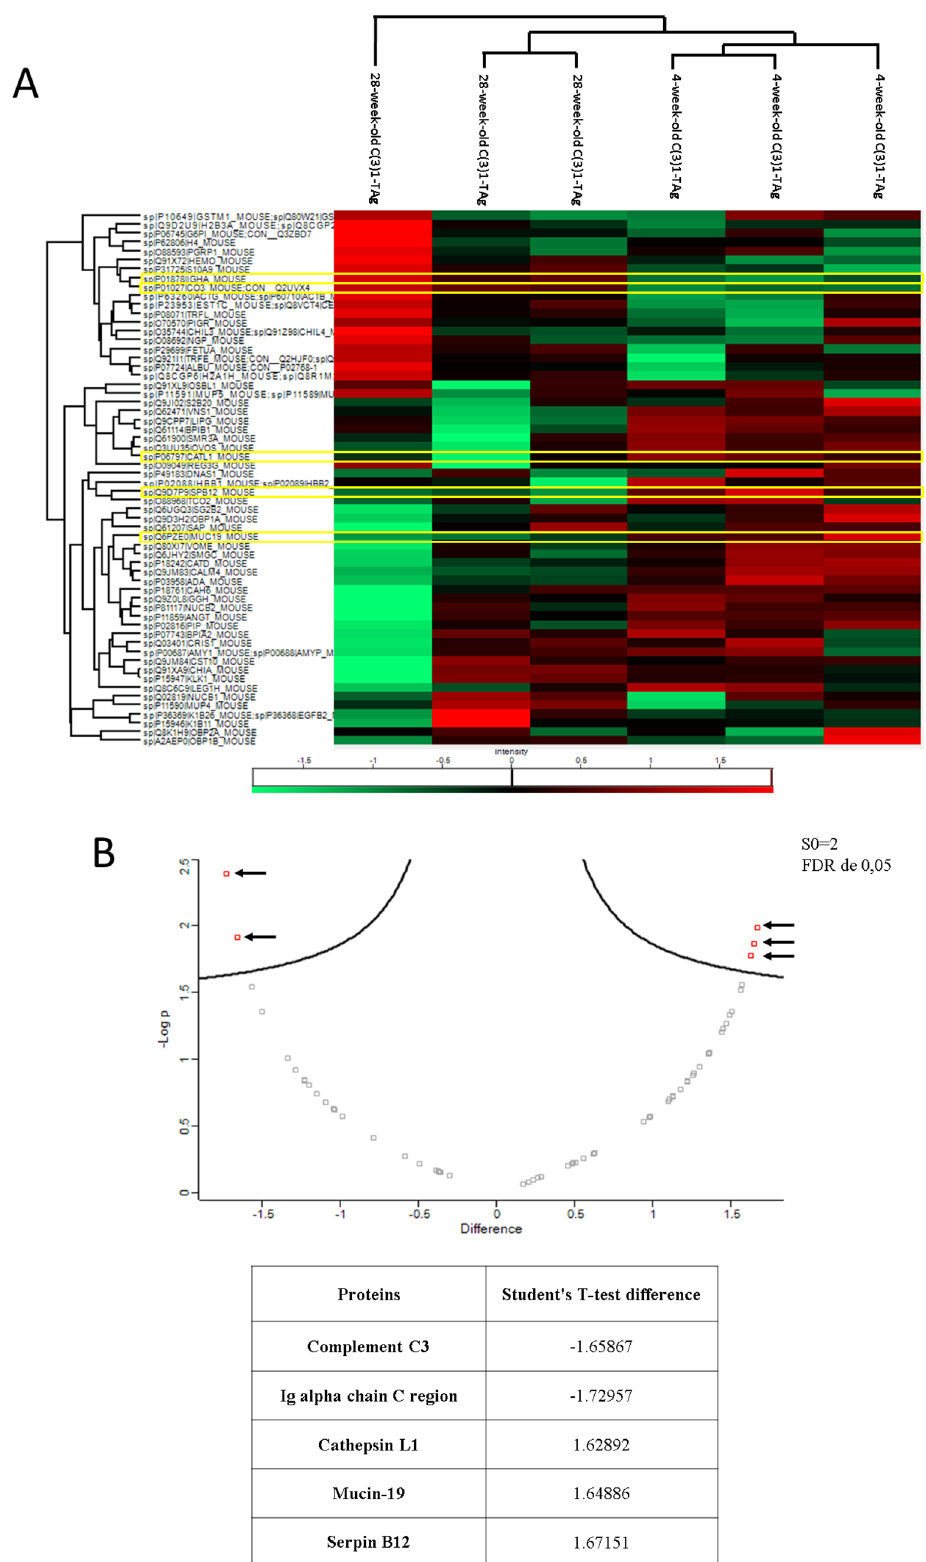
Figure 5. Differential protein expression in the saliva of C3(1)-TAg animals at 4-week and 28-week time points. ( A ) Heatmap comparing 4-week-old and 28-week-old C(3)1-TAg. The proteins that differ significantly between 4-week-old C(3)1-TAg animals and 4-week-old wild-type mice are highlight in yellow. ( B ) Volcano plot showing five proteins (represented by red dots with arrows. Each red dot represents a separate gene) that are expressed differently between animals with mammary cancer in the initial stage and animals with the invasive carcinoma. A negative result demonstrates that the protein is more expressed in the 28-week-old C(3)1-TAg samples and a positive result demonstrates that the protein is more expressed in the 4-weeks-old